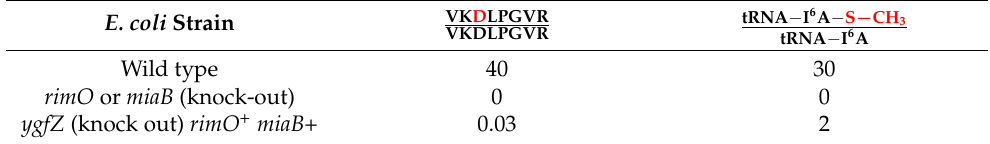
Table 4. Effect of YgfZ on the RimO and MiaB thiomethylation of S12 and tRNA, respectively (a)